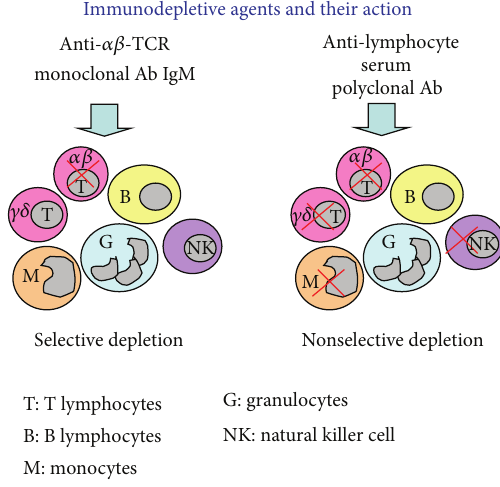
Figure 1: Selective immunodepletion under anti- 𝛼𝛽 -TCR mono- clonalantibodyandnonselectivedepletionofleukocytesunderanti- lymphocyte